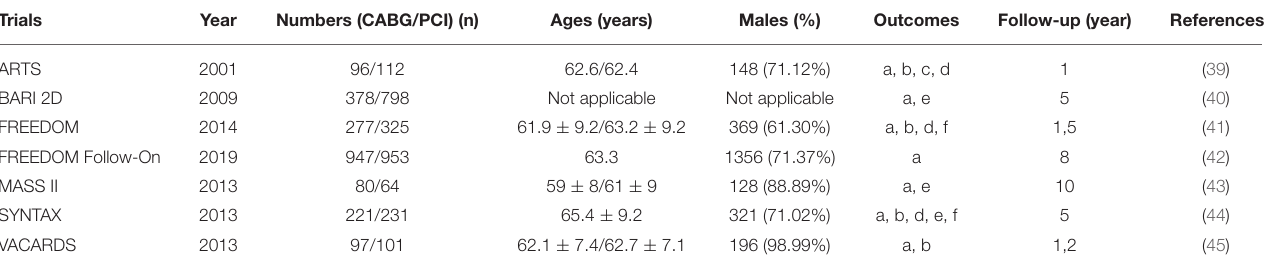
TABLE 1 | Baseline patient characteristics.